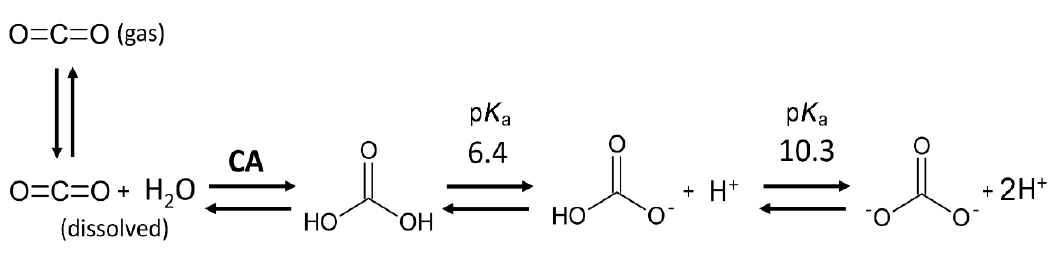
Figure 1. pH-dependent equilibria of bicarbonate. Bicarbonate (HCO 3 − ) is in pH-dependent equilibria with carbonate (CO 32 − ) and carbonic acid (H 2 CO 3 ). Carbonic acid can be converted to water and CO 2 by the enzyme carbonic anhydrase (CA). At air interfaces of the aqueous solution, dissolved CO 2 is in equilibrium with gaseous CO 2 .